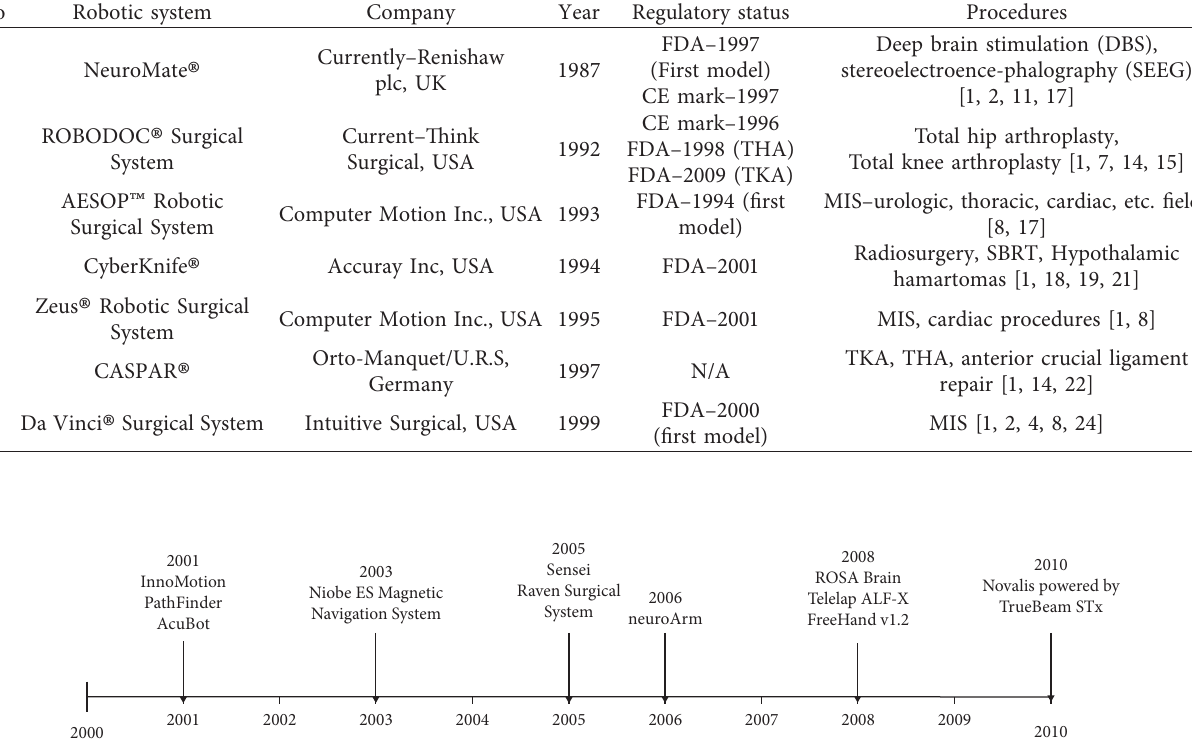
Table 1: Robotic systems that were developed during decade I, from 1990 to 2000 (first generations).